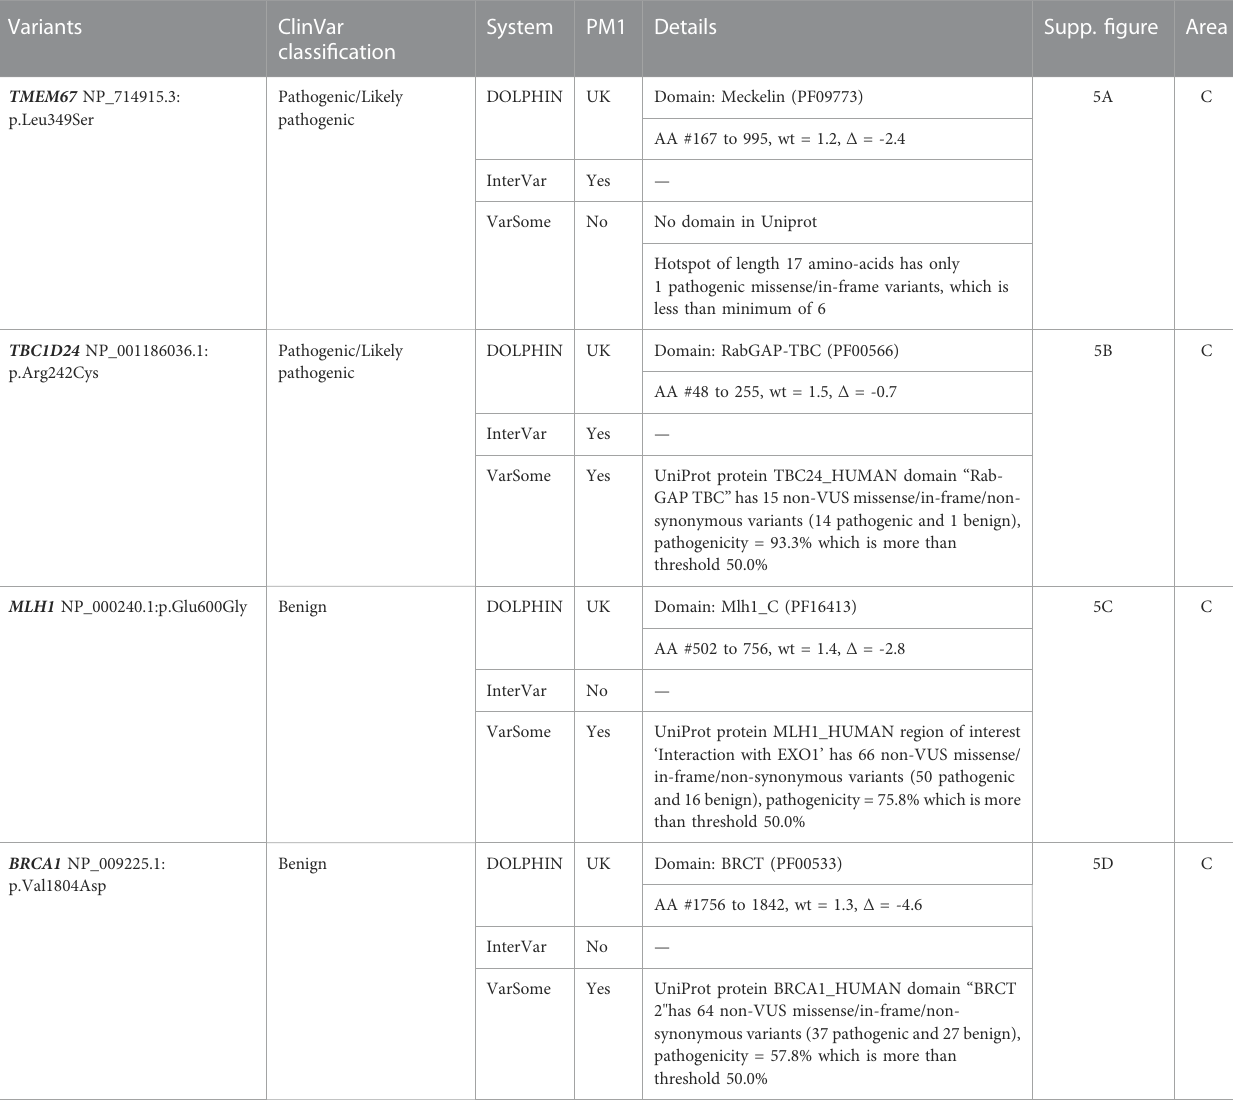
TABLE 3 False negatives and false positives of the DOLPHIN PM1 annotation based on DOLPHIN, InterVar and Varsome. AA = Amino Acid; UK = Unknown.